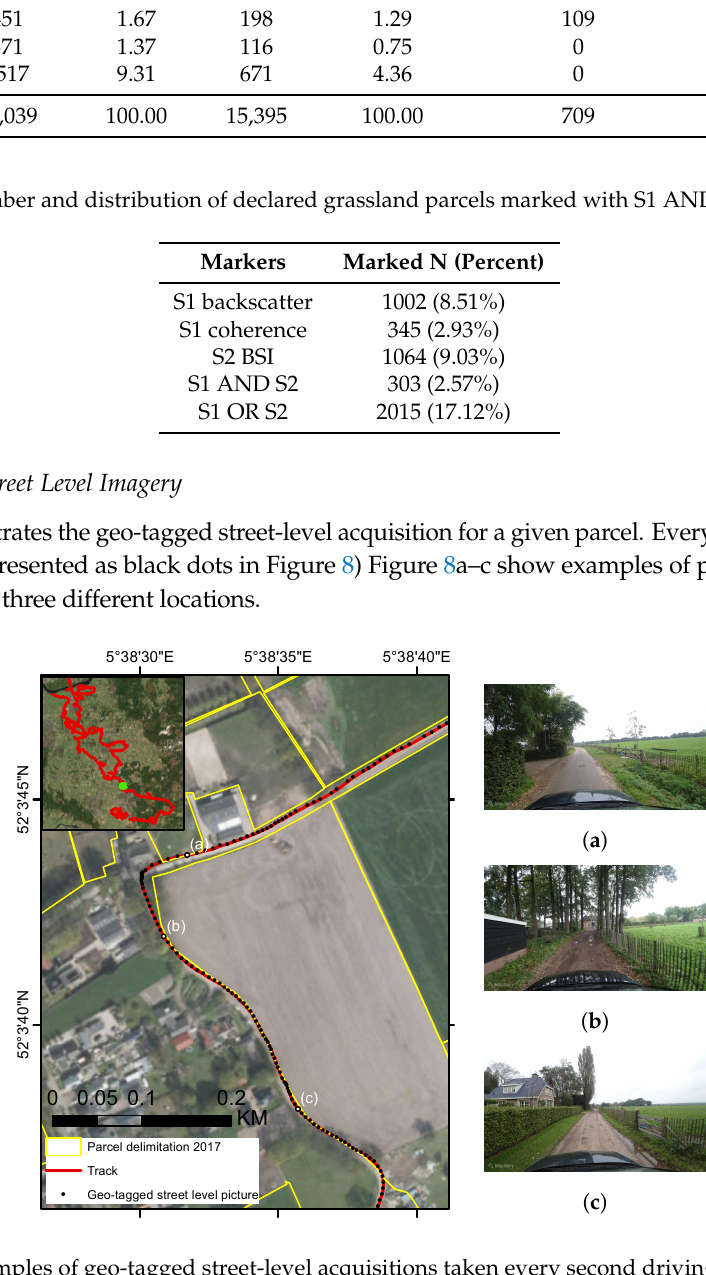
Figure 8. Examples of geo-tagged street-level acquisitions taken every second driving from south to north. Thanks to the camera’s wide angle, the parcel is observed on several geo-tagged images (e.g., ( a – c )) from different points of view, thus permitting one to deduce the crop